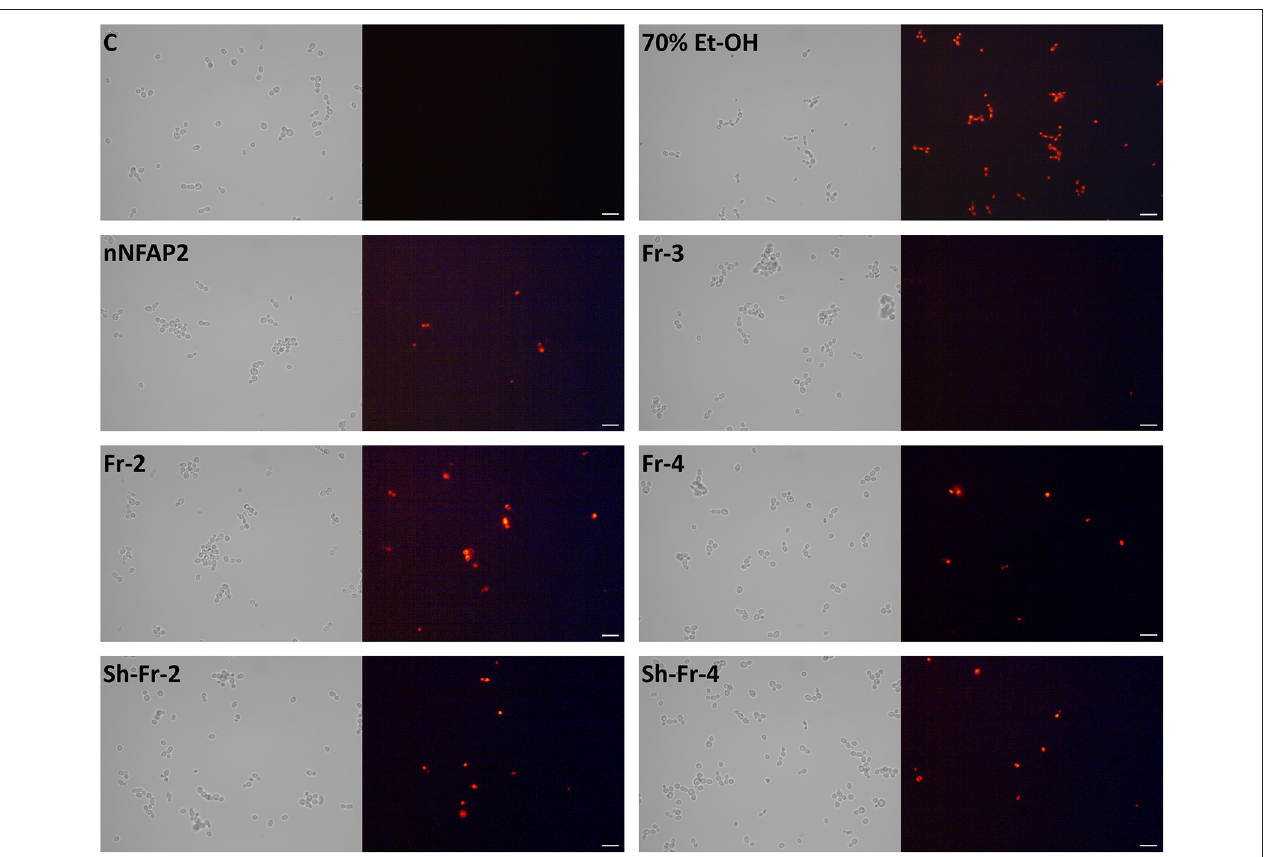
FIGURE 7 | PI staining of C. albicans ATCC 10231 cells after treatment at MIC ( Table 2 ) of nNFAP2 and its synthetic peptide fragments (Fr-2 - 4 and Sh-Fr-2 and 4) for 10min at 30 ◦ C. Scale bars represent 20 µ m. 70% (v/v) Et-OH: positive PI-staining control, C: untreated, negative control, Fr-2 - 4: synthetic peptide Fragment 2 - 4 of NFAP2 ( Table 1 ), nNFAP2: native NFAP2 produced by N. fischeri NRRL 181, Sh-Fr-2 and 4: shuffle variants of synthetic peptide Fragment 2 and 4 of NFAP2 ( Table 1 ).